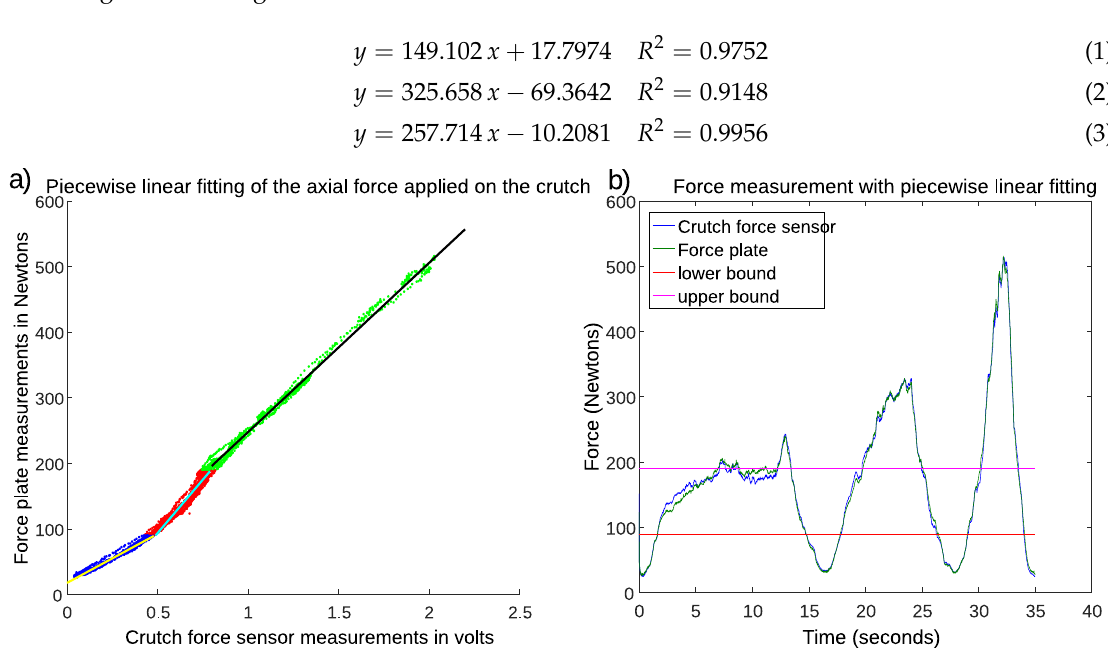
Figure 2. Results with force data of the first recording. ( a ) Best-fitting straight lines for each cloud. ( b ) Evolution of force measurements after